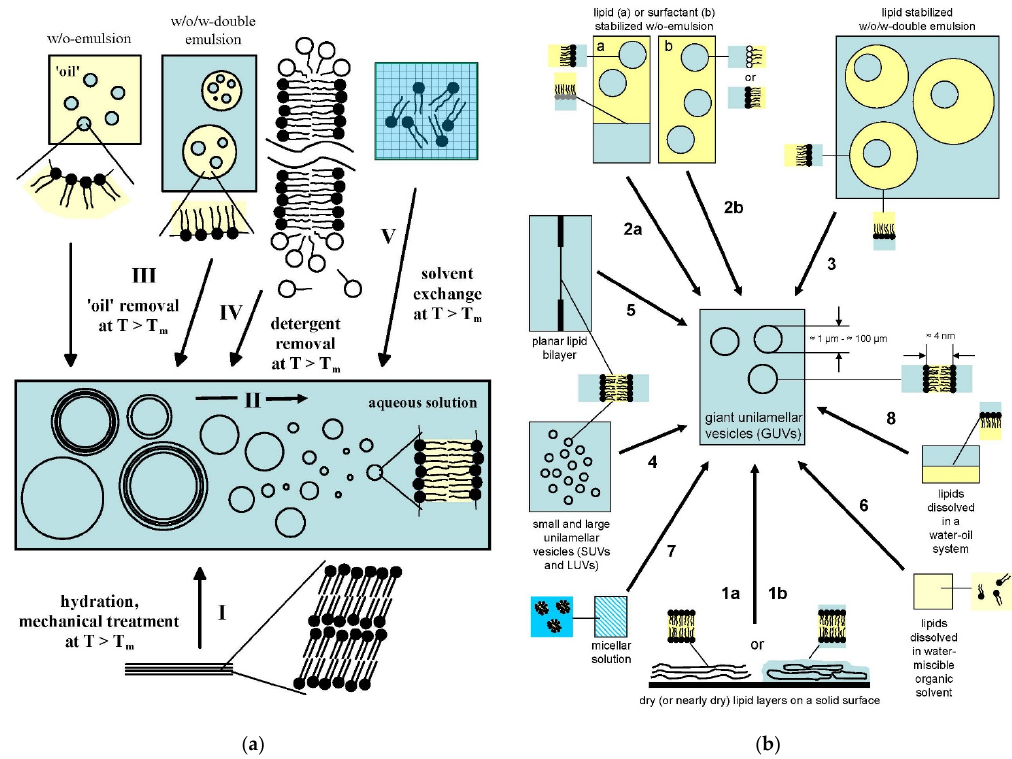
Figure 17. Schematic representation of the concepts of some of the methods that were developed for the formation of ( a ) large unilamellar vesicles (LUVs), with diameters in the range of 100 nm, and ( b ) giant unilamellar vesicles (GUVs), with diameters above 1 µ m. ( a ) Multilamellar vesicles (MLVs) are usually obtained by dispersing a dry film of bilayer-forming lipids at T > T m in an aqueous solution (I). The obtained MLV dispersion can be sized down to LUVs by polycarbonate membrane extrusion at T > T m . Sonication of MLVs yields sonicated (or small) unilamellar vesicles (SUVs). The reduction in vesicle size and lamellarity is represented by “II” as process from left to right in the horizontal box. Sub-micrometer-sized unilamellar vesicles can also be obtained from w / o -emulsions or w / o / w -double emulsions containing bilayer-forming lipids (III, well-known is the “reverse-phase evaporation method”); from an aqueous solution of mixed detergent-lipid micelles (IV, “detergent removal method” or “detergent depletion method”) or from an ethanolic solution containing bilayer-forming lipids (V, known as “ethanol injection method”). ( b ) GUVs can be obtained by a careful hydration of a thin film of bilayer-forming lipids deposited on a solid surface (1a and 1b, “spontaneous hydration method” in its simplest version). The hydration may be done on a conducting surface in the presence of an electric field (“electroformation method”). With these methods (1a,1b), the GUVs usually remain attached to the surface at the place where the lipids originally were deposited. Other methods for GUV formation are based on the initial formation of micrometer-sized water droplets in a water-immiscible oil, followed by either the transfer of the droplets from the oil into an aqueous solution (“droplet transfer method”, 2a), or by first freezing the droplets, followed by coating with lipids in the frozen state and hydration during droplet melting (“lipid-coated ice droplet hydration method”, 2b). In alternative procedures, the initial states of the lipids are either in the form of w / o / w -double emulsions (3), dispersions of SUVs or LUVs (4), planar lipid bilayers (5), lipids dissolved in a water-miscible organic solvent (dioxan or tetrahydrofuran, for example, 6), micelles (7), or a water-oil system (8). For details of the different procedures, see text and the original literature cited in the two references where the schemes were published first [191,192]. Reproduced with small modifications from [191], American Scientific Publishers, 2004, and with permission from [192], WILEY-VCH Verlag GmbH & Co. KGaA,